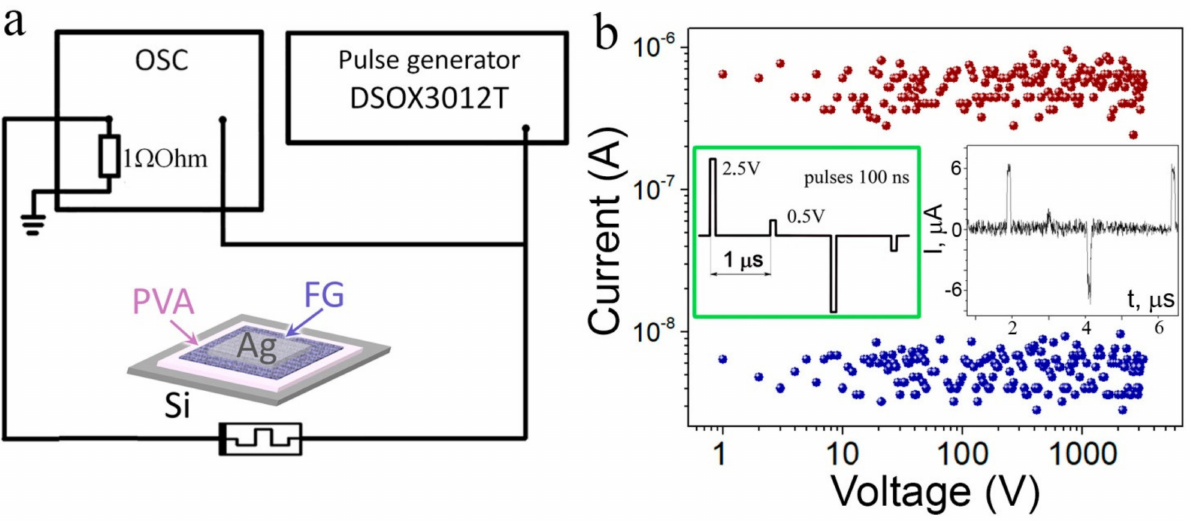
Figure 7. Current switchings for the structure irradiated with Xe ions (167 MeV, 3 × 10 11 cm − 2 ) with the FG thickness of 17–20 nm: ( a ) Circuit for measuring the pulse characteristics; ( b ) The I ON and I OFF currents as a function of pulse number. The sketches of the measured structures and the tested voltage pulses are given in the insets of ( a ) and ( b ), respectively. The second inset in ( b ) presents the Set-read-Reset-read cycle for the tested